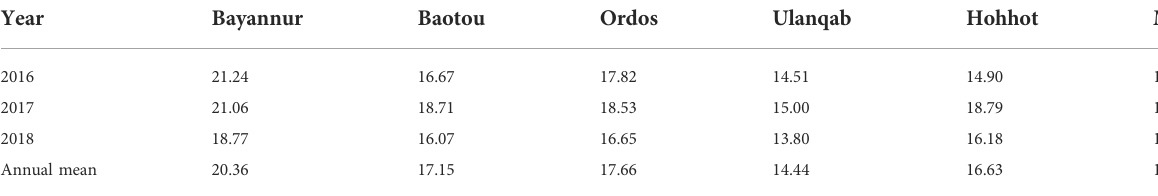
TABLE3DescriptionofthestatisticalcharacteristicsoftheannualmeanPM2.5concentration( μ g/m 3 )ofcitiesincentralInnerMongoliafrom2016to 2018. Year